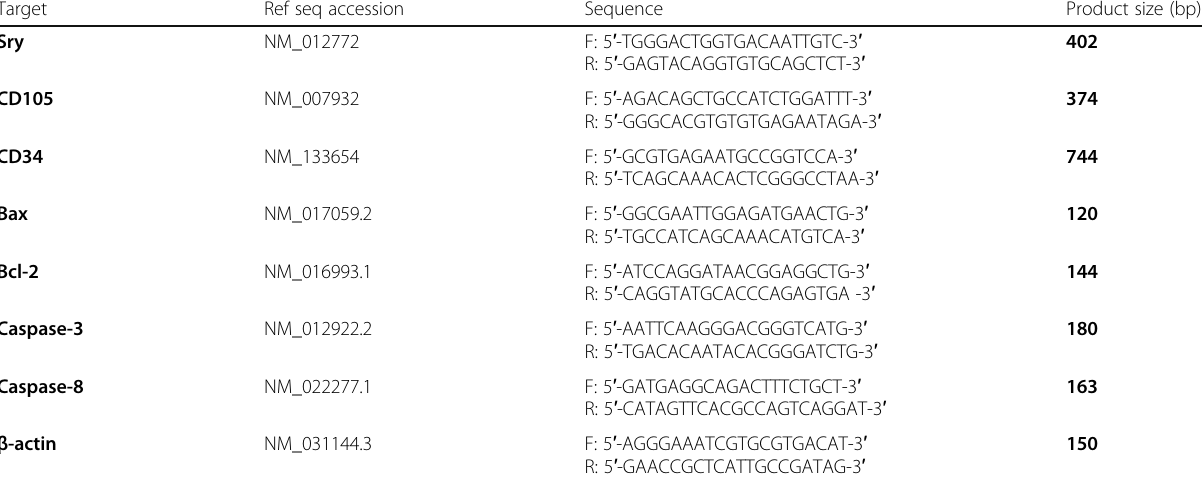
Table 1 Primers sequence of Sry, CD105, CD34, Bax, bcl2, caspase-3, caspase-8, and β -actin genes